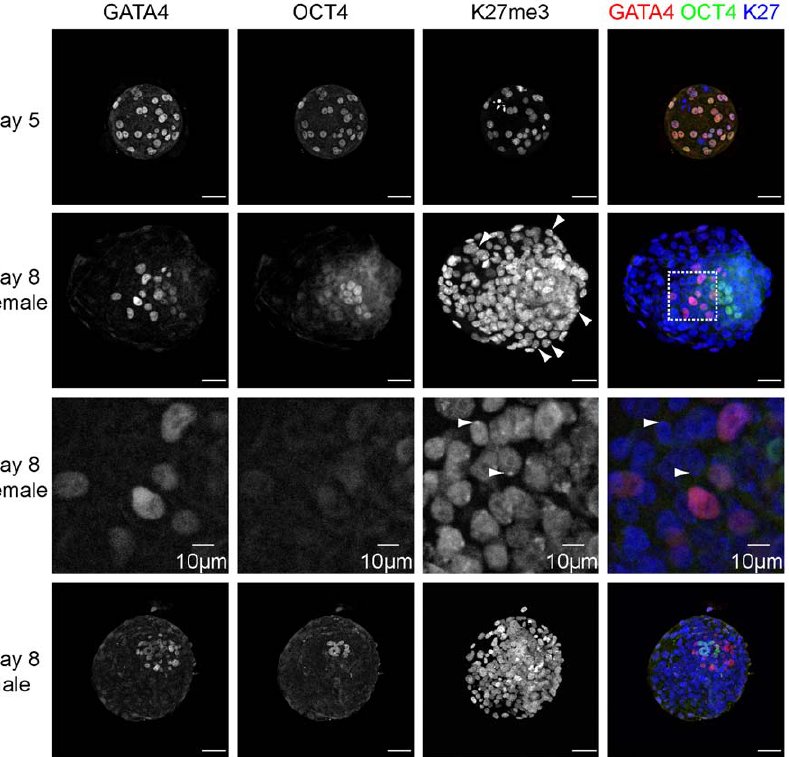
Figure 5. Lineage development and H3K27me3-accumulation on the X-chromosome in human embryos. Expression of GATA4, OCT4, and H3K27me3 in human day 5 pre-implantation and embryos that have been co-cultured with decidualized endometrial cells for 72 h (day 8). Foci of H3K27me3 are diagnostic for an inactivated X-chromosome. Arrowheads denote H3K27me3 foci. The third row panels are enlargements of the indicated area in the merge panel in the above row. Scale bars are 50 m m unless denoted otherwise.